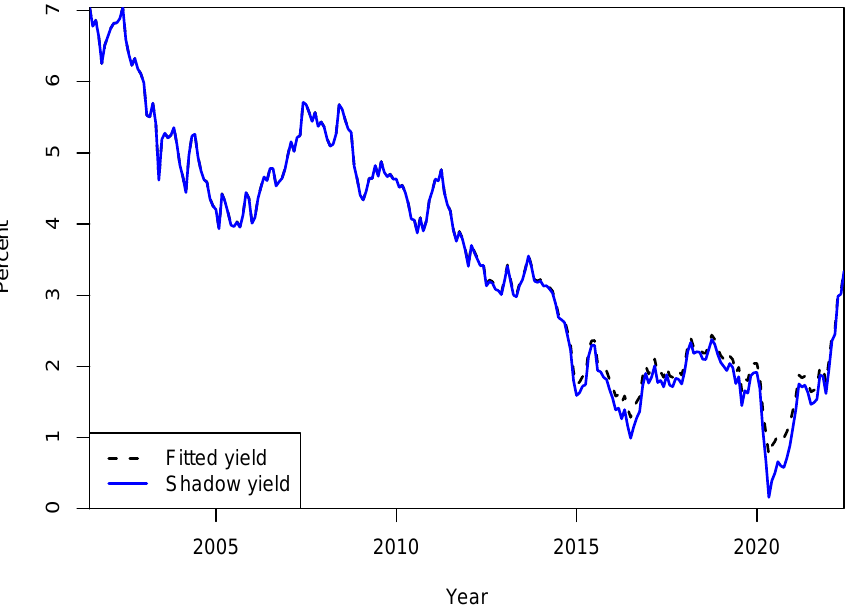
Figure 6. ZLB wedge (10 y IRS). The fitted 10-year BR yield and the corresponding shadow yield. The ZLB wedge is the difference between the two. Sample period: 2001/04 to 2022/06. Until 2015, the ZLB does not seem to have been binding in the NGB market, with probabilities of negative future rates close to zero and shadow yields not far from fitted rates. The only subperiod in the sample where BR produces different yield curve dynamics compared with JSZ is a relatively short period subsequent to the COVID-19 outbreak in March 2020. Norges Bank lowered the policy rate to zero, leading to a spike in the difference between fitted yields and shadow yields—referred to as the ZLB wedge . Towards the end of the sample, long-term yields increase—predominantly due to risk of higher inflation—and the ZLB wedge reverts back to pre-COVID-19 levels. In the interim 2015-2020 period, the lower bound seems to have been effective to some extent. However, the ZLB wedge varied in the range of 20 to 40 basis points, which most likely is not sufficient to significantly impact term